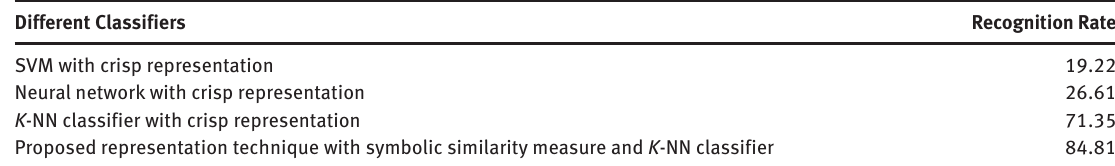
Table 3: Results Obtained by the Different